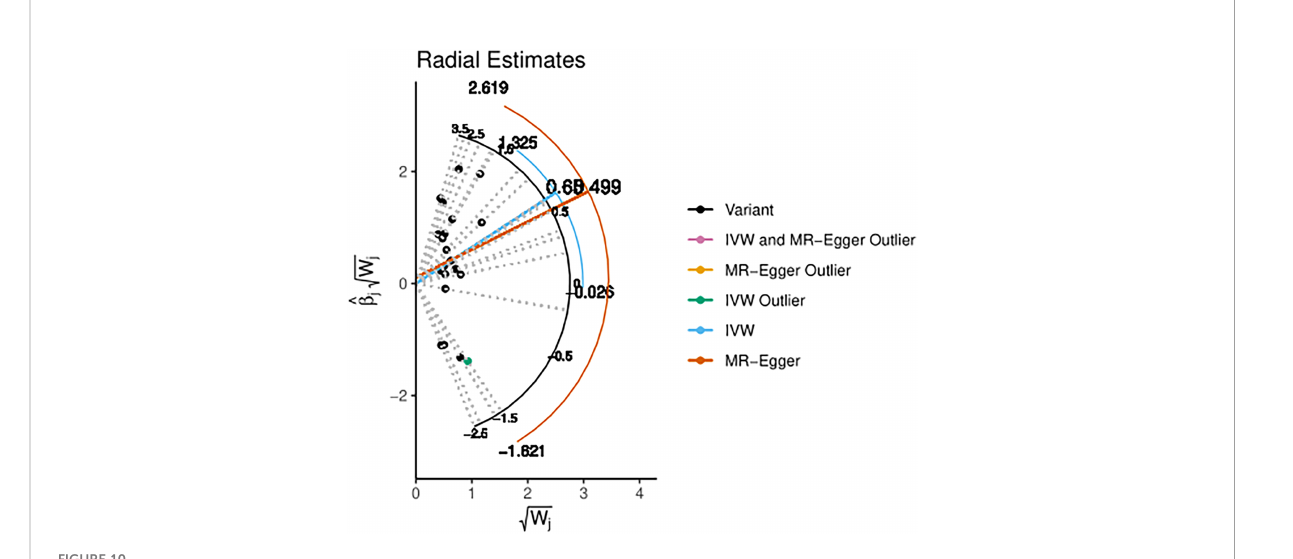
FIGURE 10 Diagram of the radial estimates (BN !